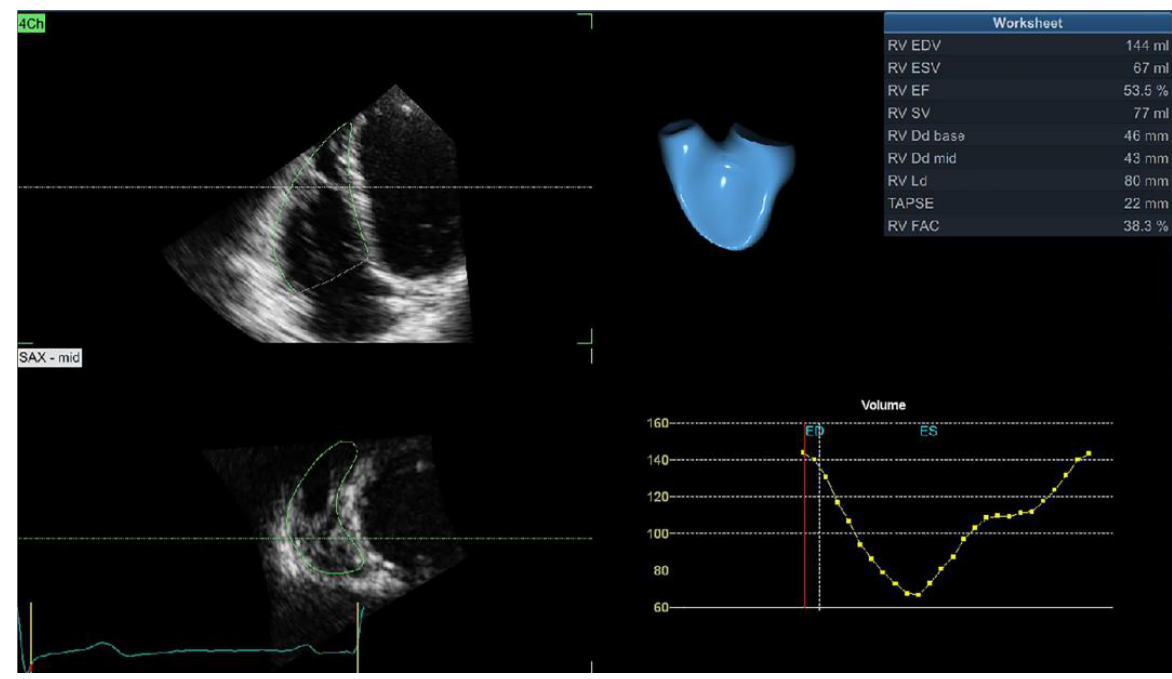
Figure 1. 3D echocardiographic evaluation of right ventricular volume and ejection fraction.